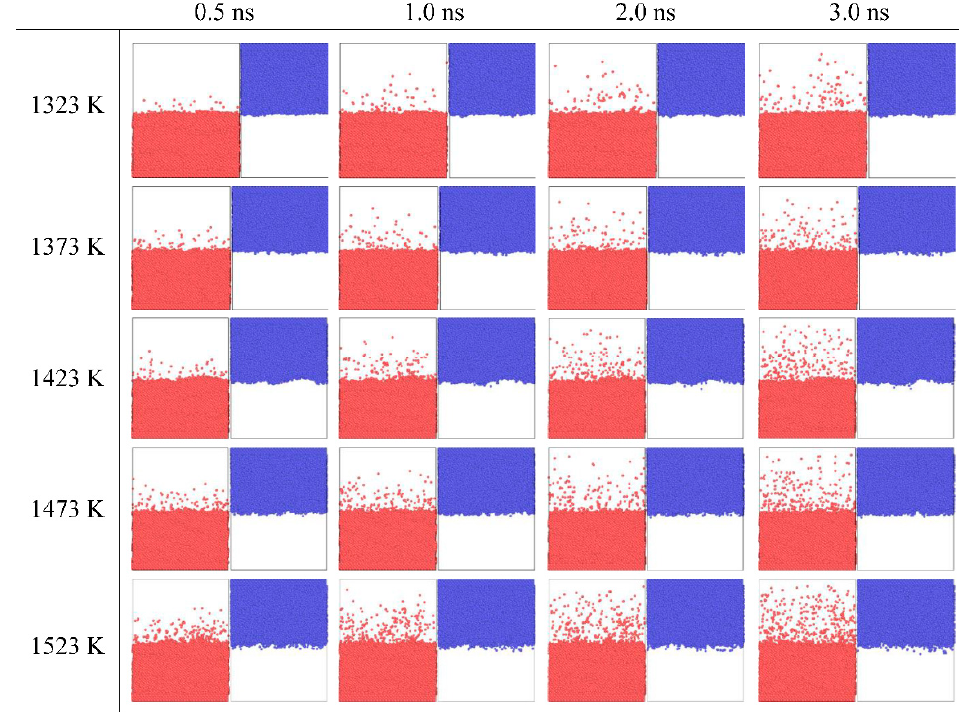
Figure 2. Snapshots of Fe atoms and Cu atoms under different diffusion times and temperatures. Red is Fe, blue is Cu.